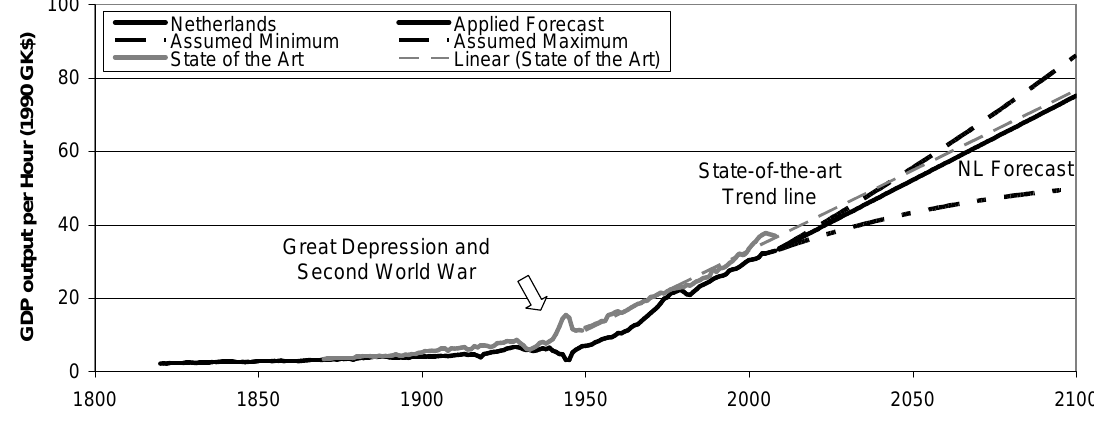
Figure 11: Assumed development of the Labour Productivity The gray line indicates the hourly labour productivity for the most productive country in the world. This line is referred to as state-of-the-art . The black line indicates development for the Netherlands. Both lines show a trend breach at the instance of the Great Depression and Second World War. The state-of-the-art trend line shows a strong linear trend since the early 1950s 17 . The black line indicates the development of the labour productivity for the Netherlands. From the end of the Second World War the Netherlands is performing well and slowly creeping towards the state-of-the-art trend line. The forecast assumptions of the Dutch GDP per hour worked have been defined as a triangular distribution function of which the main estimate follows a linear extrapolation of the post war trend. The maximum is defined by a 15% increase imposed on the trend in 2100. This causes an upward shift of the state-of-the-art line. The minimum is defined by a 30% fall compared to the long term trend in 2100. The downward risk is perceived larger than the upward risk as it is not difficult for a country to fall behind (the analysed data provided many examples of such behaviour). Shifting the state-of-the-art trend line to a higher level is however far more